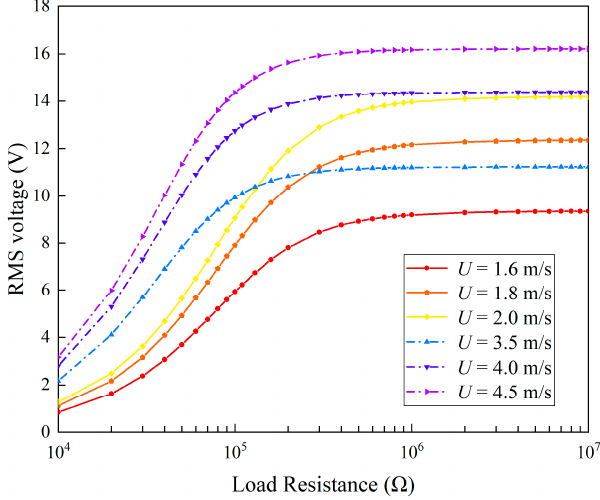
Figure 17. Variation of RMS voltage with load resistance at different wind speeds.